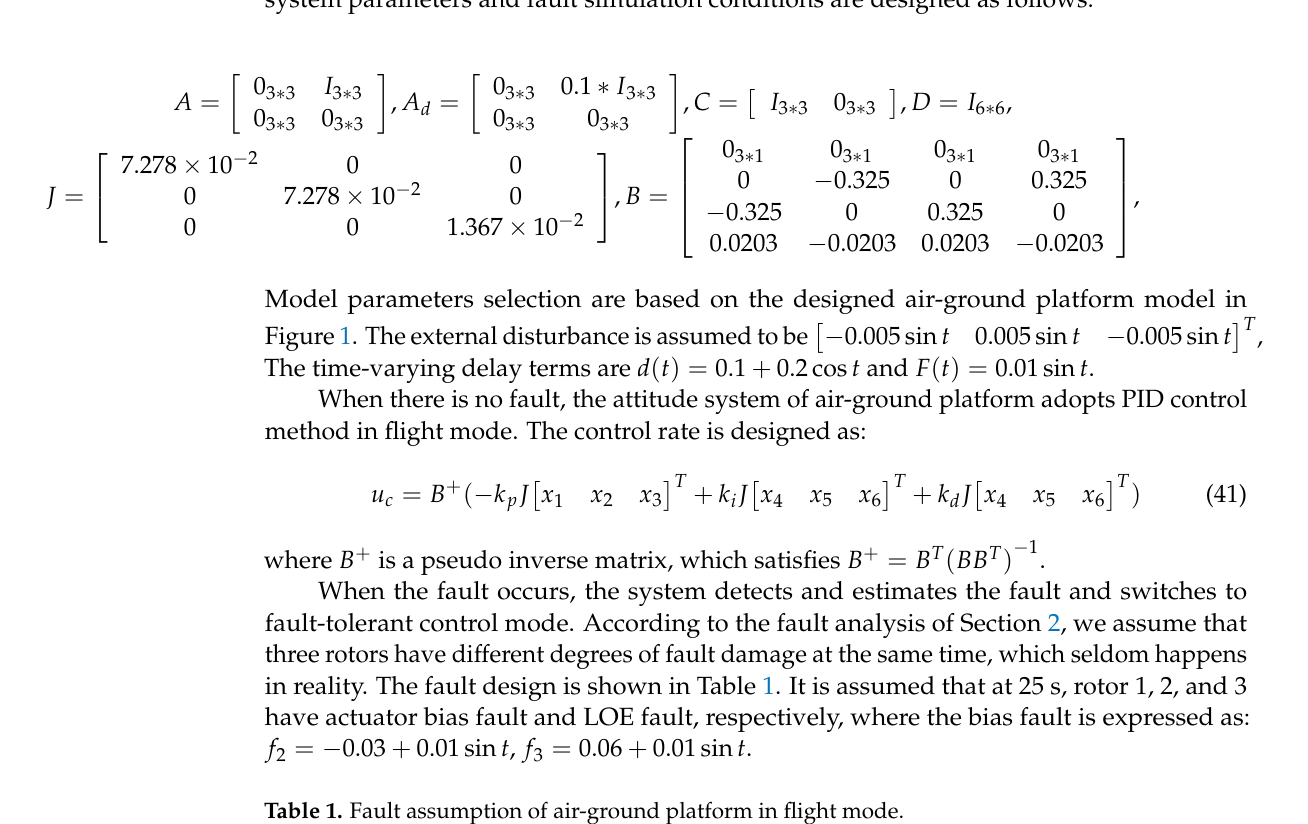
Table 1. Fault assumption of air-ground platform in flight mode. Rotor Rotor 1 Rotor 2 Rotor 3 Rotor 4 Fault Type LOE 0.5 0.2 Normal Normal Bias Fault None f 2